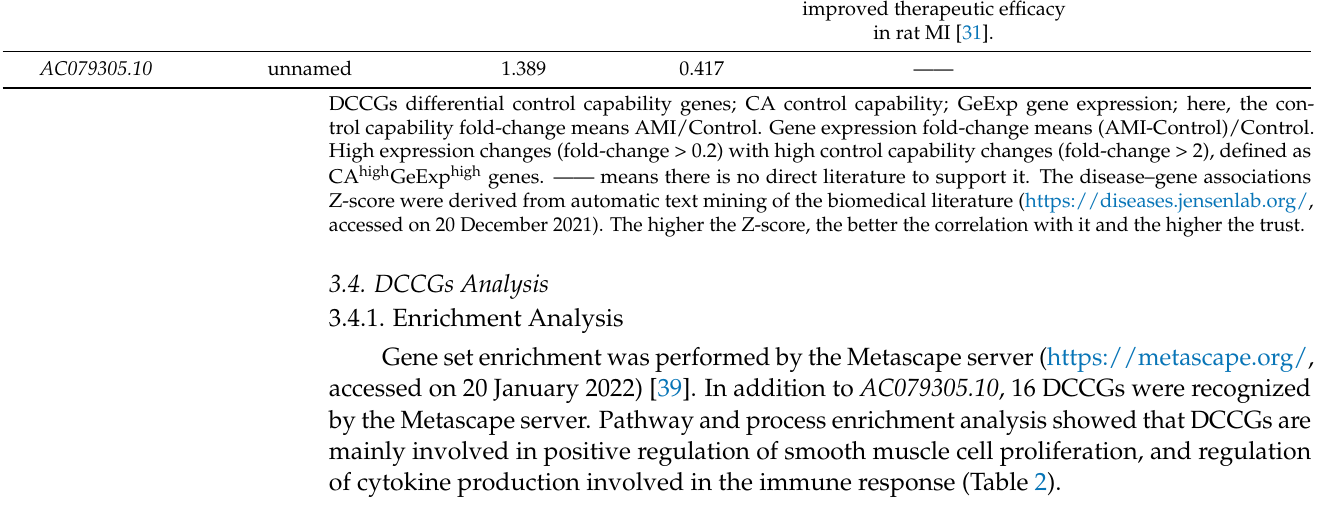
Table 2. Top seven gene enrichment outputs of